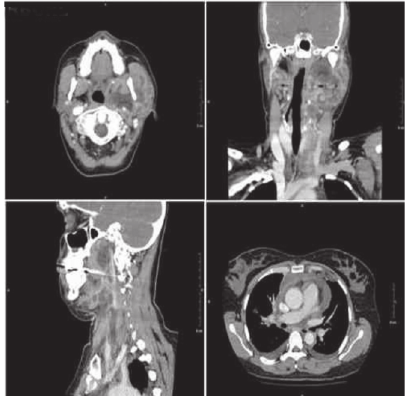
Figure 1 Computed tomography showing large abscess affec- ting multiple cervical spaces and extending into the anterior